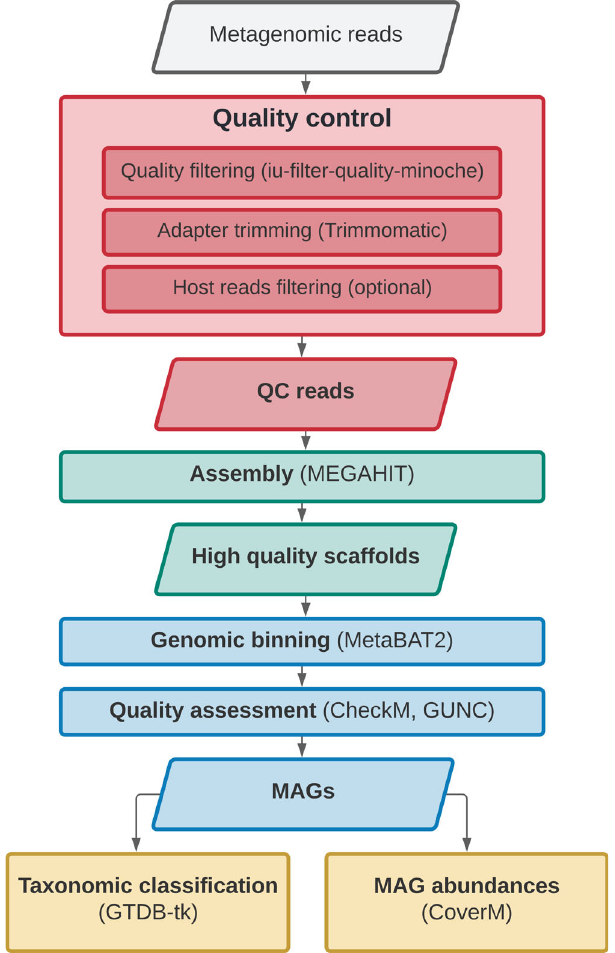
Figure 1. Directed acyclic graph describing the main steps performed by SnakeMAGs v1.1.0. The names of the software used for each step are showed in